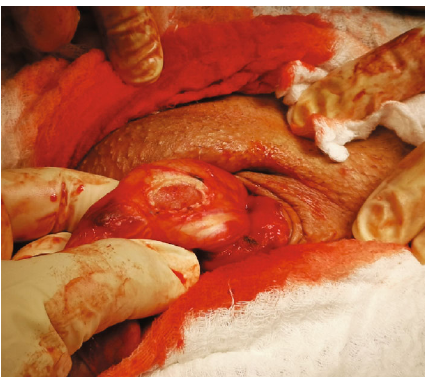
Figure 9: State after resection by “ lengthening ” method before patch implantation (Drlik